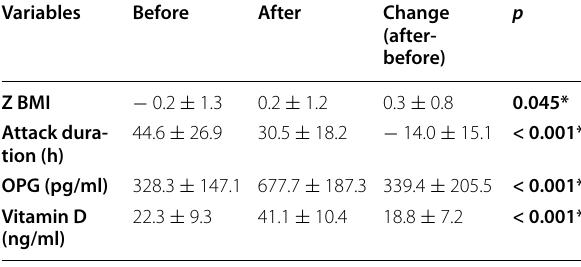
Total 33. Data expressed as mean = ^Paired t test. *Significant